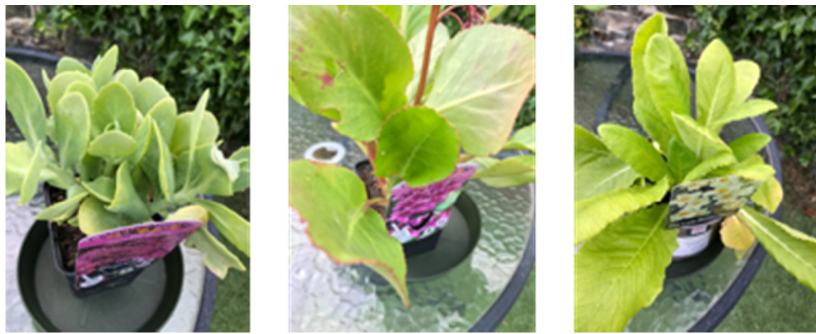
Figure 1. Left to right: Sedum spectabile , Bergenia cordfolia and Primula vulgaris . Table 1. Basic properties of Sedum spectabile , Bergenia cordfolia and Primula vulgaris . Plant 1, Sedum spectabile Plant 2, Bergenia cordfolia Plant 3, Primula vulgaris Small ‘succulent species’ leaf type. Drought tolerant. Evergreen, flowering plant. Dense canopy. Expected low ET .